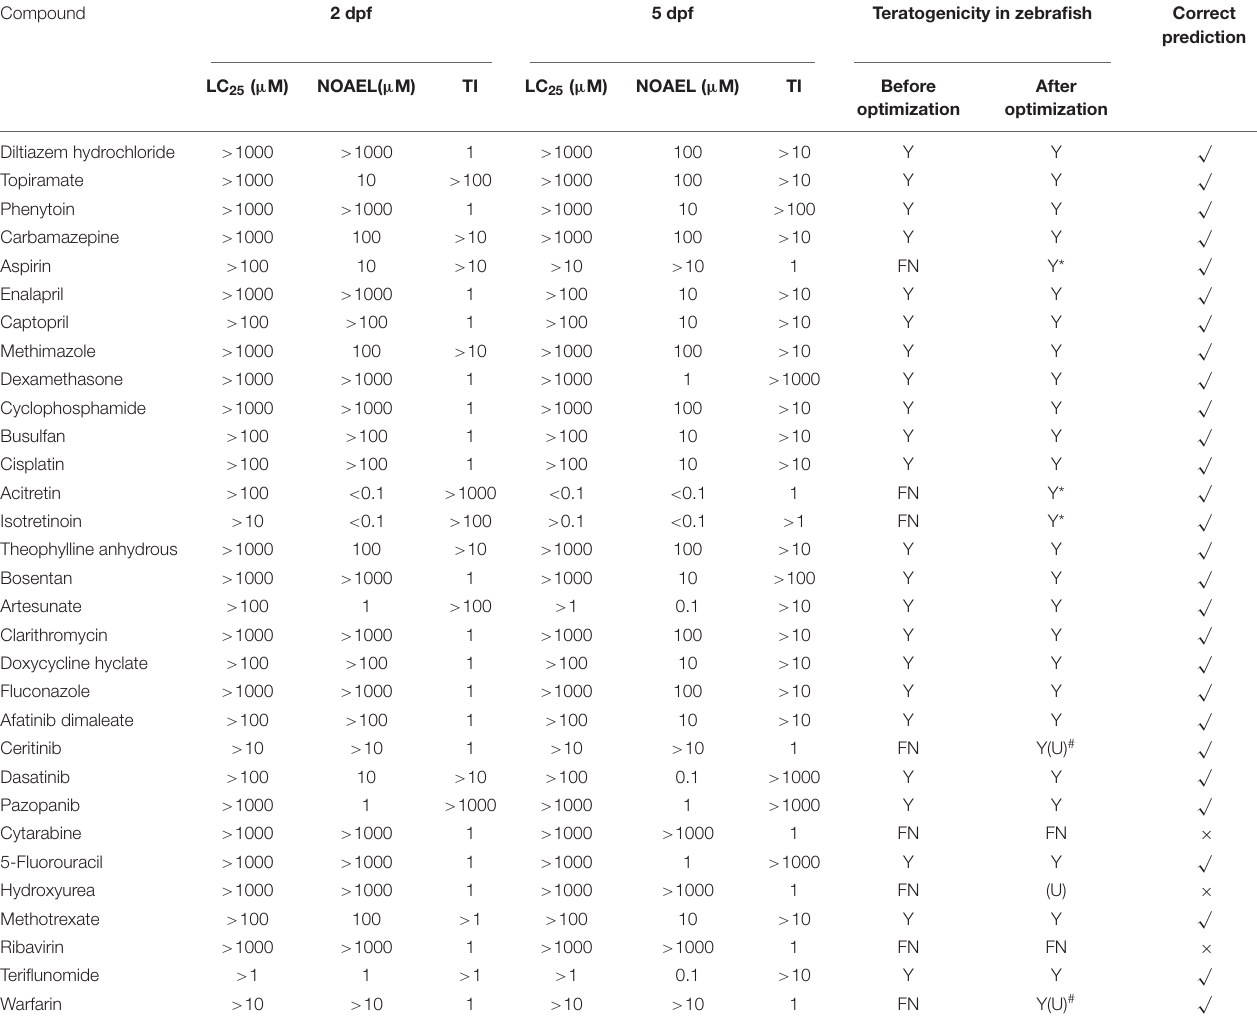
TABLE 3 | Developmental toxicity results of positive controls (teratogen) compounds in zebrafish. Compound 2 dpf 5 dpf Teratogenicity in zebrafish Correct